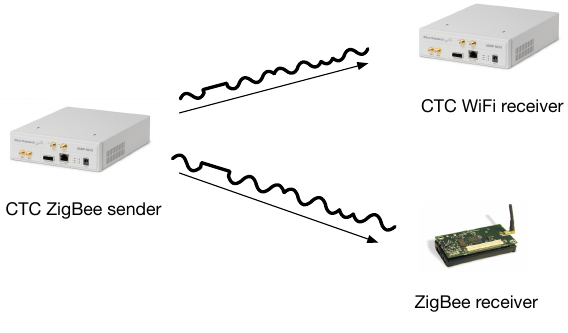
Figure 11. Experiment setup.